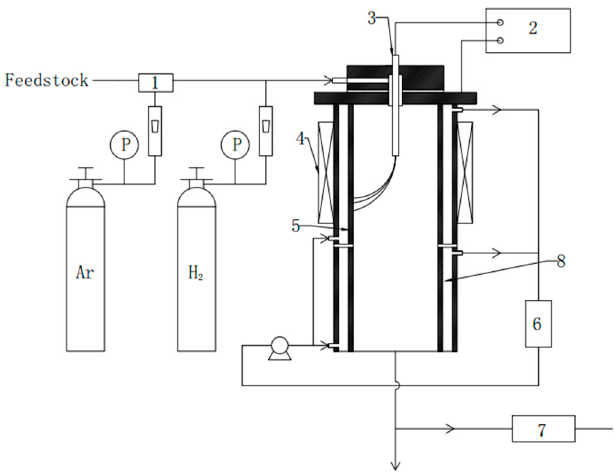
Figure 1. Schematic diagram of 50 kW rotating DC arc plasma reactor. 1—material feeder, 2—DC